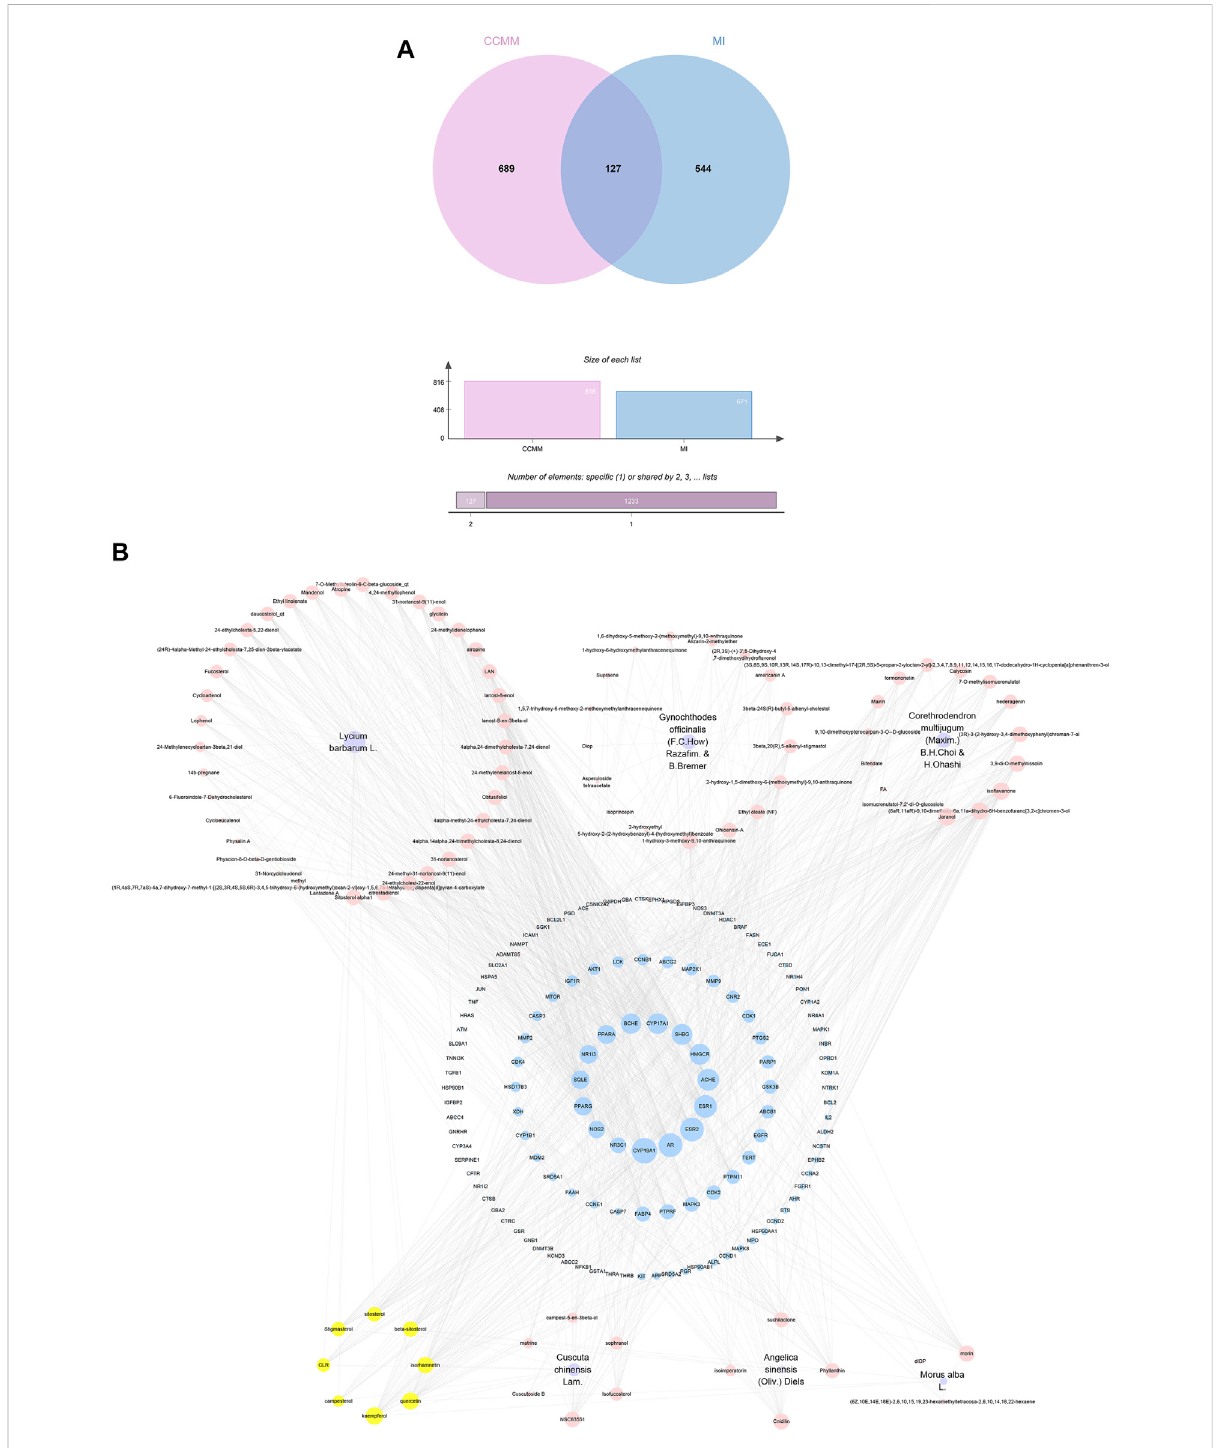
FIGURE 4 CCMM-MI common targets and network. (A) The Venn diagram ’ s intersection: CCMM and MI overlap 127 targets. (B) CCMM-MI common- targetnetwork.PurplenodesstandforherbsofCCMM.Pinknodesrepresentbioactivecomponentsfromeachherb.Yellownodesindicatebioactive componentsthatappearmorethanoncefromdifferentherbs.BluenodesstandforthecommontargetsofCCMMandMI.Thediameterofthecircle denotes the target protein ’ s node